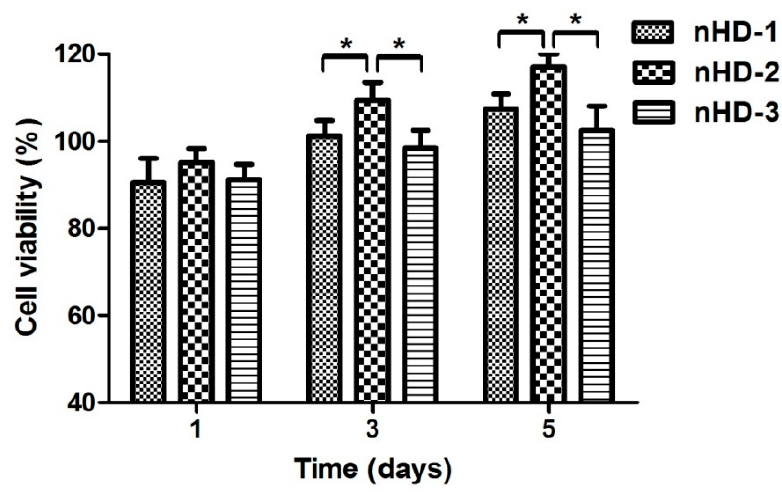
Figure 6. The osteoblast MC3T3-E1 cell viabilities of three nHD scaffolds’ extract solutions after 1, 3, and 5 days of incubation; * p < 0.05.